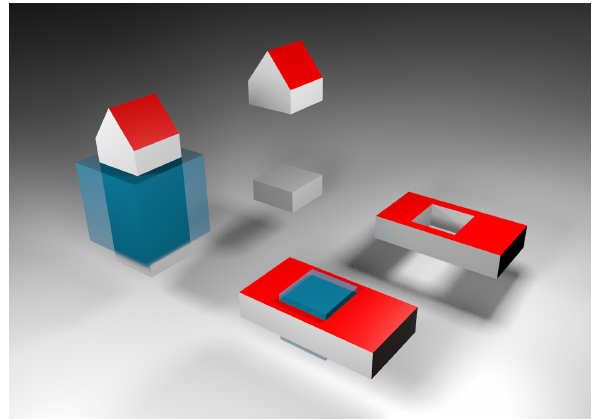
Figure 8: Intersection strategies for dividing the voxels. The tall building on the front left shows the intersection of the building edges with the blue voxel whose vertices are all outside of the building model. The flat building on the front right shows the in- tersection of the voxel edges with the building. The faulty results obtained when not using additional intersection tests are illus- trated by the buildings in the rear part of the figure.